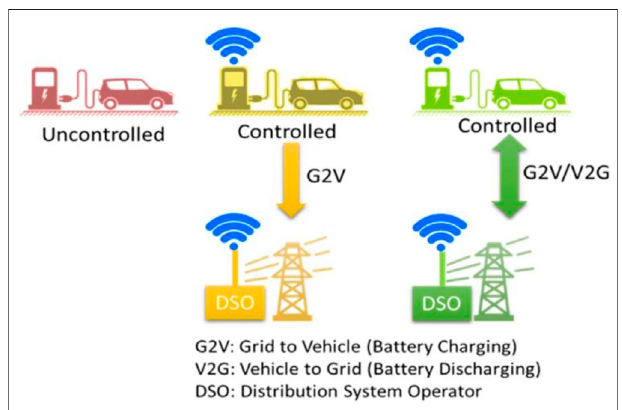
FIGURE 3 | Various options for the integration of EVs in a smart